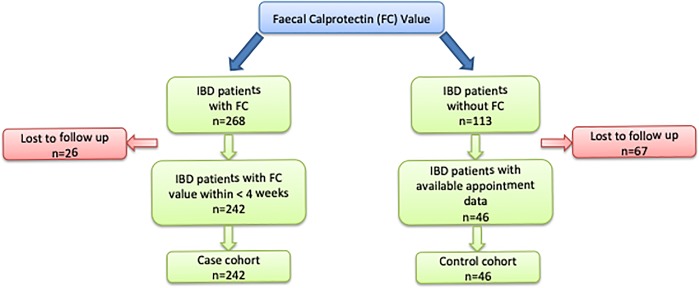
In- and exclusion of IBD patients dependent on the availability of a faecal calprotectin value within 4 weeks after their appointment.